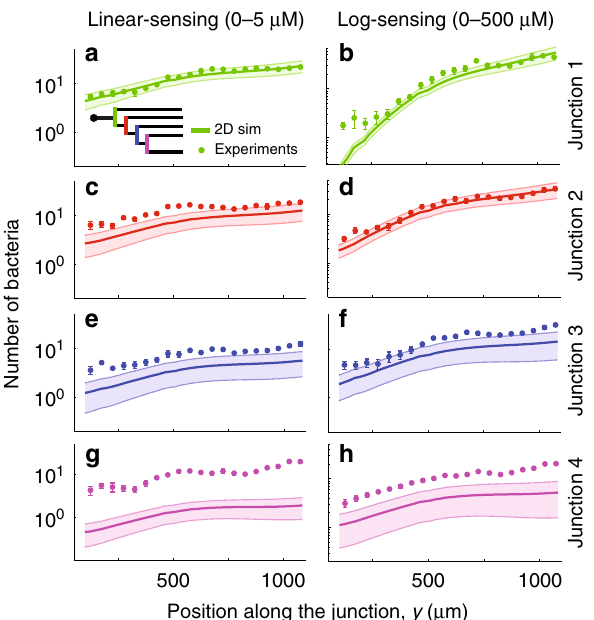
Fig. 3 Accumulation pro fi les of bacteria at the four maze junctions for a monoclonal E . coli population responding to a methylaspartate gradient. Panels show the absolute number of bacteria observed at points along each T-junction (circles, mean ± s.d. from three replicates) in the linear-sensing ( a , c , e , g ) and log-sensing ( b , d , f , h ) regimes. Lines show the expected number of bacteria from the simulations. The shaded con fi dence interval shows the variation in the simulation solution over the time interval of the experiments (40 – 160 min). Bacteria are introduced at the inlet in the maze at t = 0 min (see Fig. 1) and disperse over time into the maze (see Supplementary Fig. 2 for the accumulation pro fi les at two different time points). The chemotactic sensitivity in the simulations was fi tted to best match the experimental pro fi les at junction 1. Higher numbers of bacteria are found at later junctions in the maze compared to the simulations performed with a chemotactically homogeneous population of cells, as a consequence of the sorting